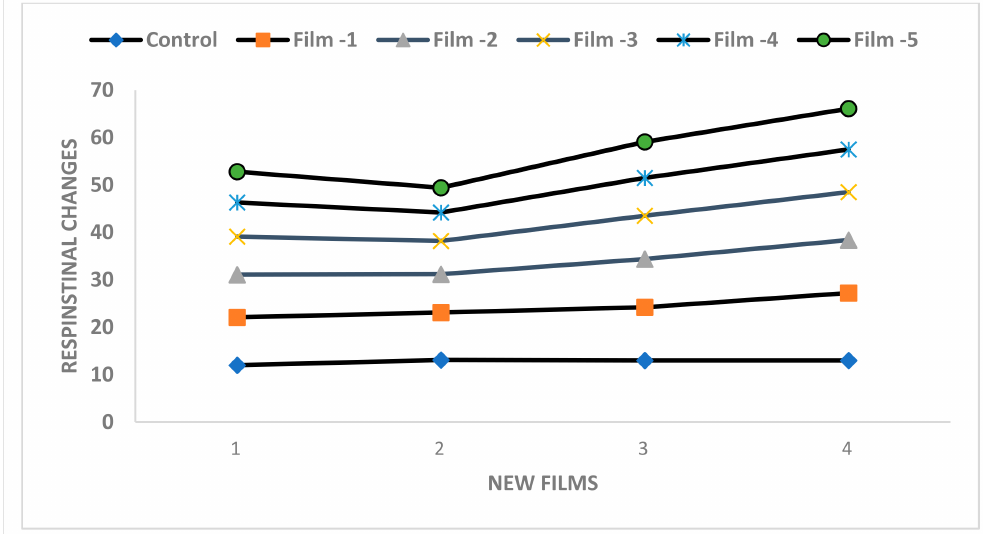
Figure 6. Respirational changes in apple fruits at storage periods with new